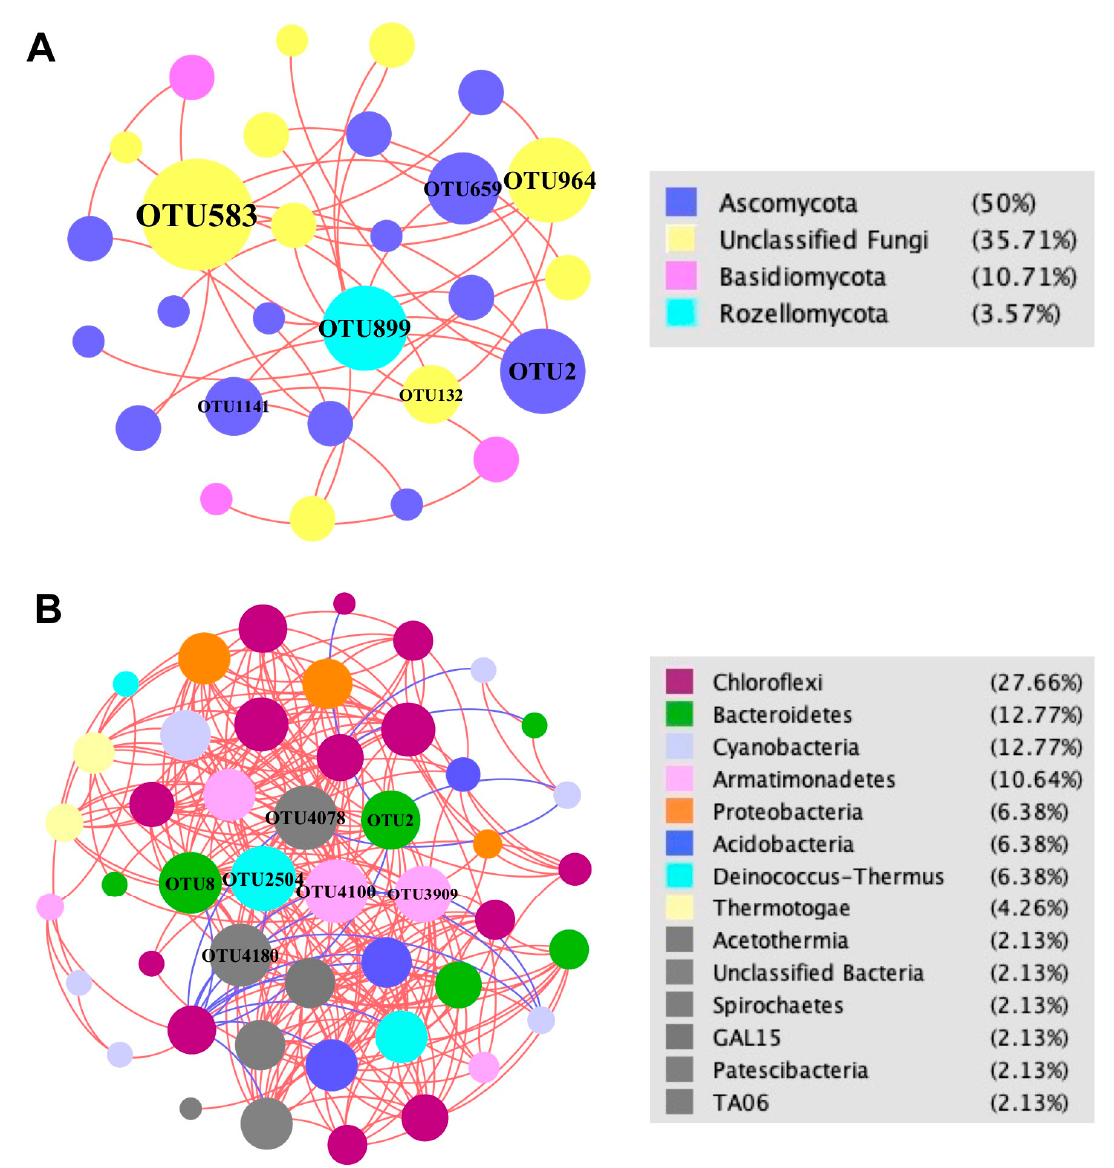
Figure 10. Sediment OTUs network analysis of the Julong hot springs (Fruchterman–Reingold layout). ( A ) Network of fungal community; ( B ) network of bacterial community. Each node represents an OTU indicating a single species. Color codes for nodes belonging to different dominant phyla. The node size is proportional to the degree (degree: number of direct correlations to a node). Positive interactions are displayed as red edges and negative interactions are displayed as blue